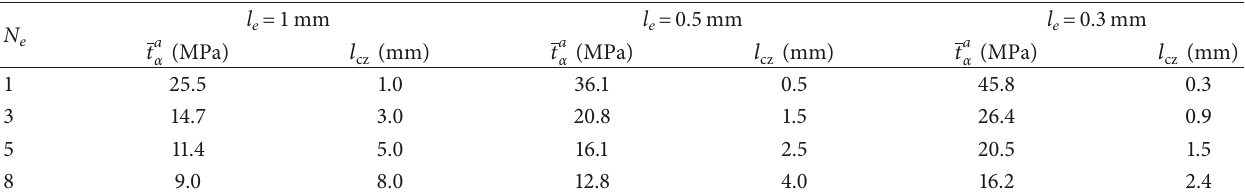
Figure 6: Finite element validation of the C-C configuration: (a) load-displacement curve and (b) fracture energy-crack extension. Table 2: Adjusted normal interfacial strength with respect to different mesh